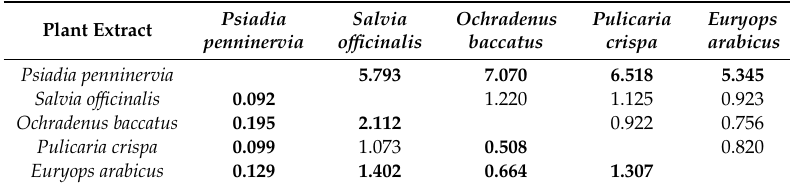
Table 5. Relative susceptibilities of 2nd larval instar of Chrysoperla carnea and adults of Aphis craccivora to methanol extracts from five medicinal plants